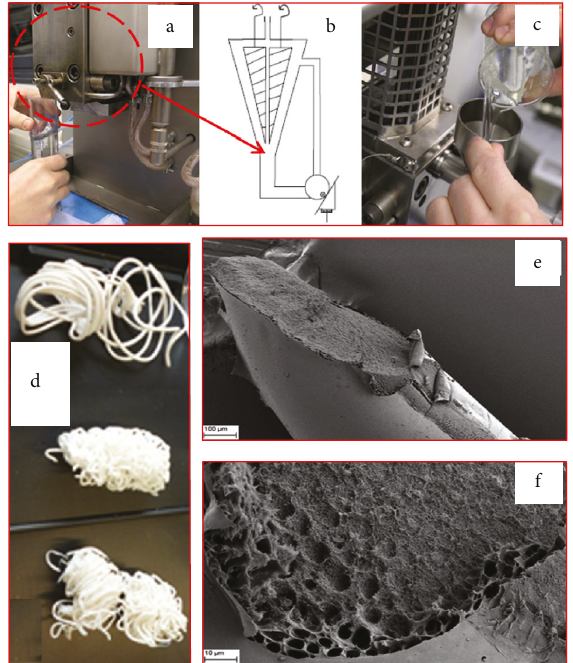
Figure 16: (a, b) Two conical, fully intermeshing corotating twin screws; (c) filling of a viscous cellulose-salt melt hydrate solution into an extruder; (d) cellulose aerogel fibers; (e-f) SEM images of 3 wt% cellulose aerogel fibers produced by twin screw extrusion exhibiting a mantle-core structure